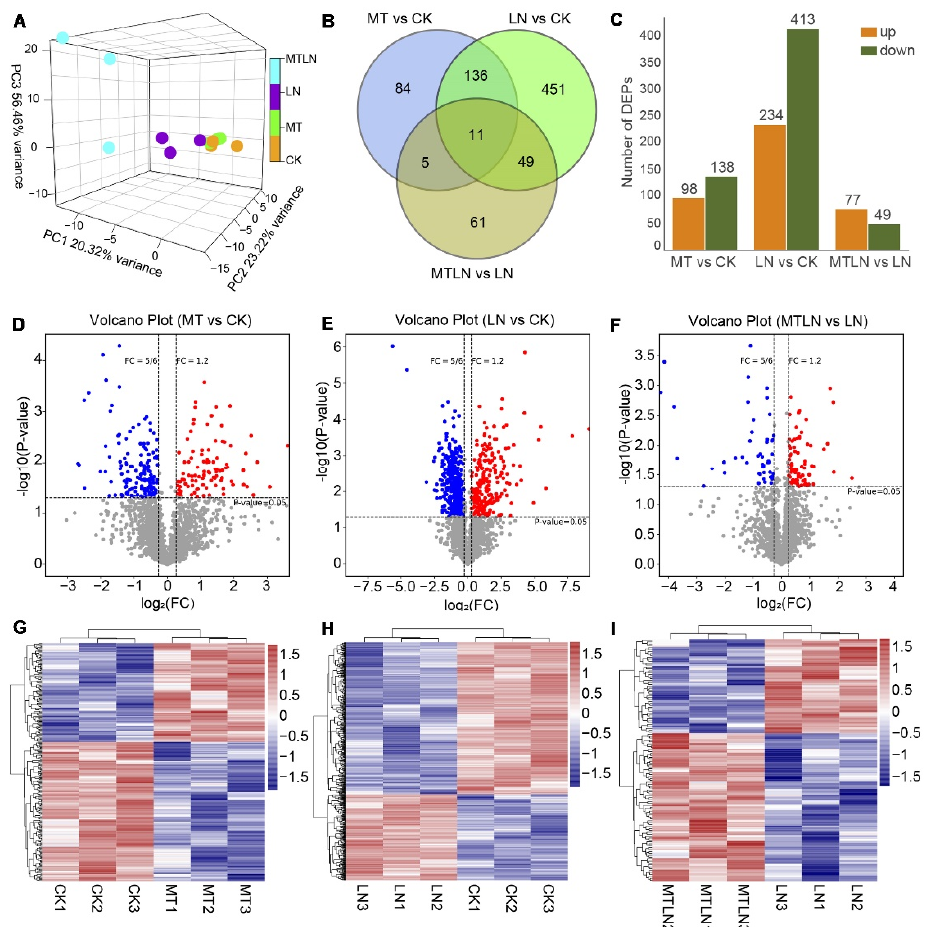
Figure 7. Analysis of differentially expressed proteins (DEPs) of melatonin-treated and untreated tomato plants subjected to low night temperature. Principal component analysis (PCA) ( A ); the number of DEPs ( B ); Venn diagram of DEPs ( C ); volcano plot of DEPs between MT and CK ( D ); volcano plot of DEPs between LN and CK ( E ); volcano plot of DEPs between MTLN and LN ( F ); cluster heat map of DEPs between MT and CK ( G ); cluster heat map of DEPs between LN and CK ( H ); cluster heat map of DEPs between MTLN and LN ( I ).